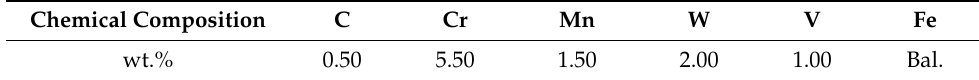
Table 3. The chemical composition of cladding H13 steel. Chemical Composition